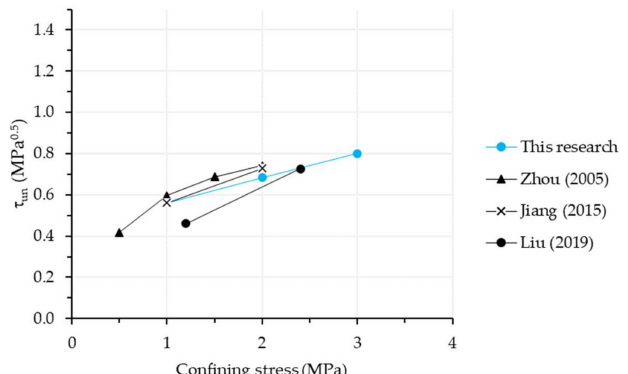
Figure 22. Maximum normalized shear stress in three-keyed dry joints obtained for specimens from ordinary (black lines) [30,40,42] and RAC (blue line).